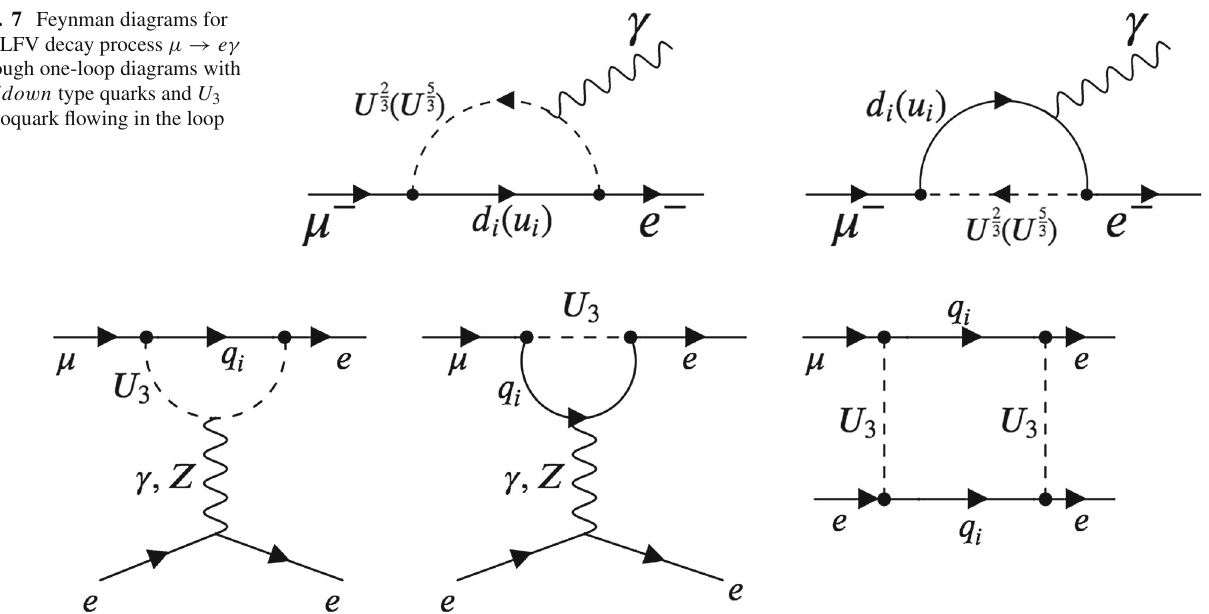
Fig. 8 Feynman diagrams for the LFV decay process μ → eee through one-loop penguin and box diagrams with up / do w n type quarks and U 3 leptoquark flowing in the